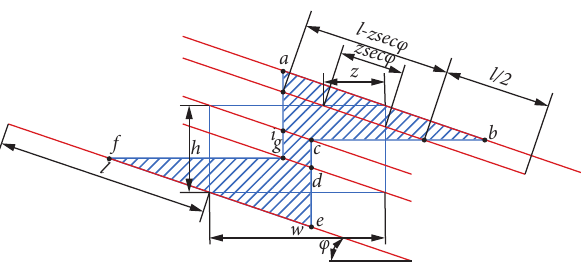
Figure 4: Traces with both ends censored, l ≥ ( h /sin φ ) and φ < tan − 1 ( h / w )